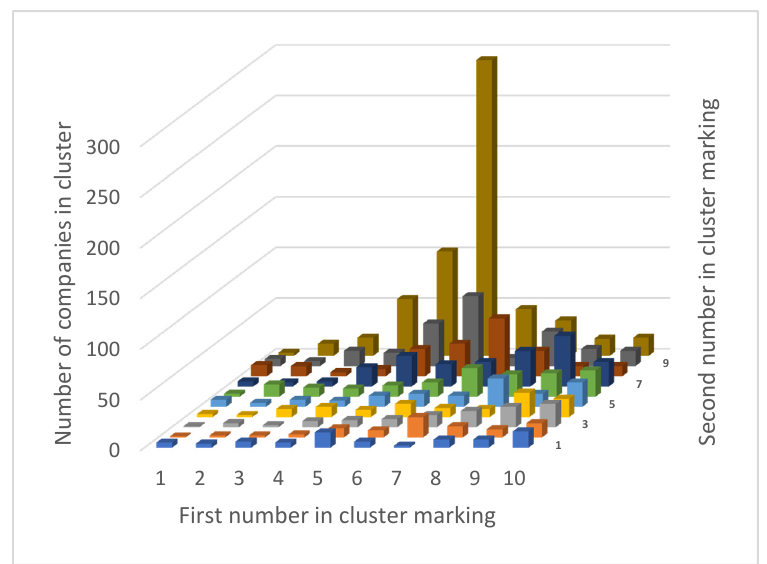
Scheme 1. Graphical representation of the number of companies in individual clusters in the year 2015. Source: Author.